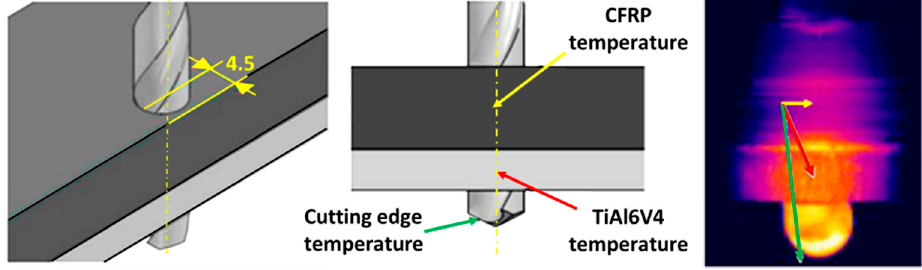
Figure 4. Temperature measurements in the stack and at the drill point.